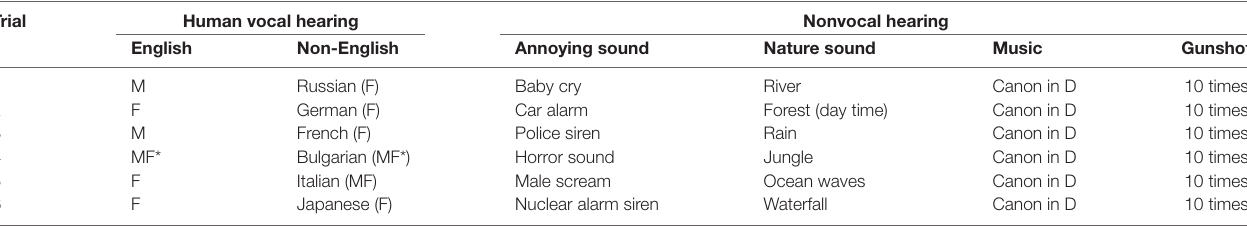
TABLE 1 | Audio categories (M: male, F: female).